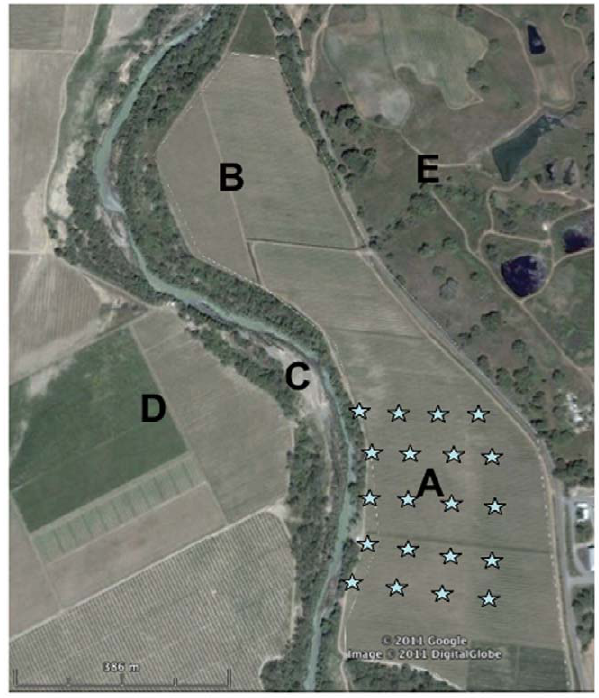
Figure 3. Aerial view of one vineyard site illustrating: (A) experimental treatment; (B) no nest box control; (C) wooded riparian zone; (D) surrounding vineyards; and (E) oak savan- nas. Within nest box treatment (A), each star indicates one pair of nest boxes mounted back-to-back 85 m from each other.